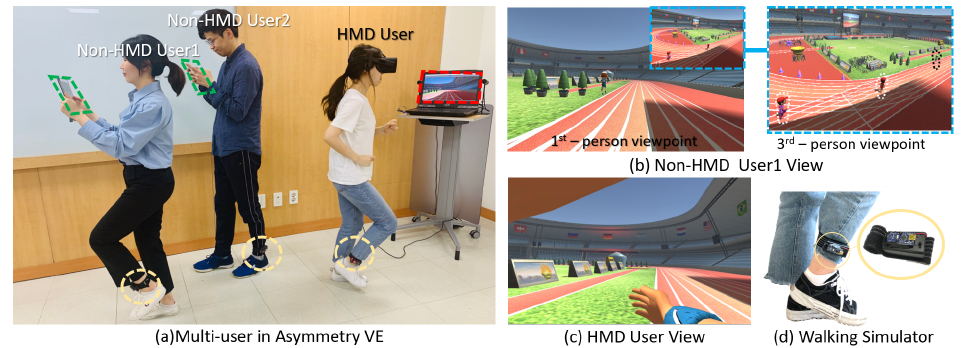
Figure 1. Our system enables a shared virtual reality (VR) experience with similar presence for both head-mounted display (HMD) and non-HMD users: ( a ) multiusers in the asymmetric virtual environment based on a low-asymmetry interface; ( b ) the non-HMD view and third-person viewpoint for a non-HMD user; ( c ) the HMD view; and ( d ) immersive walking